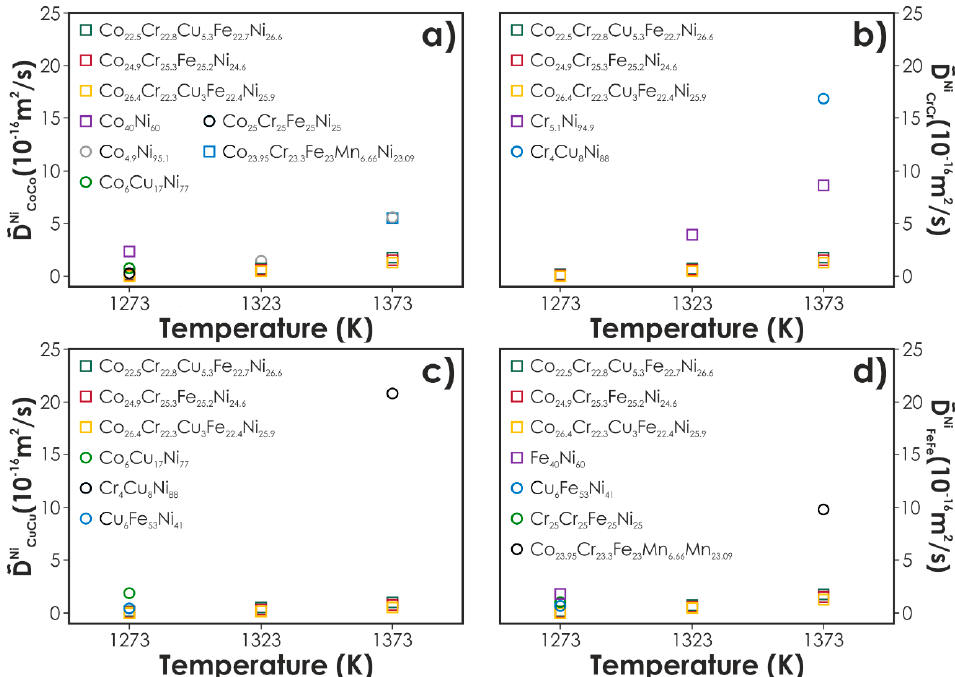
Figure 13. Comparisons of diagonal interdiffusivities determined for the Co-Cr-Cu-Fe-Ni system, with the reported experimental diffusion data at 1273, 1323, or 1373 K in various subsystems of FCC CoCrCuFeNi system with Ni as the solvent (after [37]). Reprinted from Journal of Materials Science & Technology 34 (2018), Experimental and numerical studies on the sluggish diffusion in face-centered cubic Co-Cr-Cu-Fe-Ni high-entropy alloys, 434–444, Copyright 2018, with permission from Elsevier.